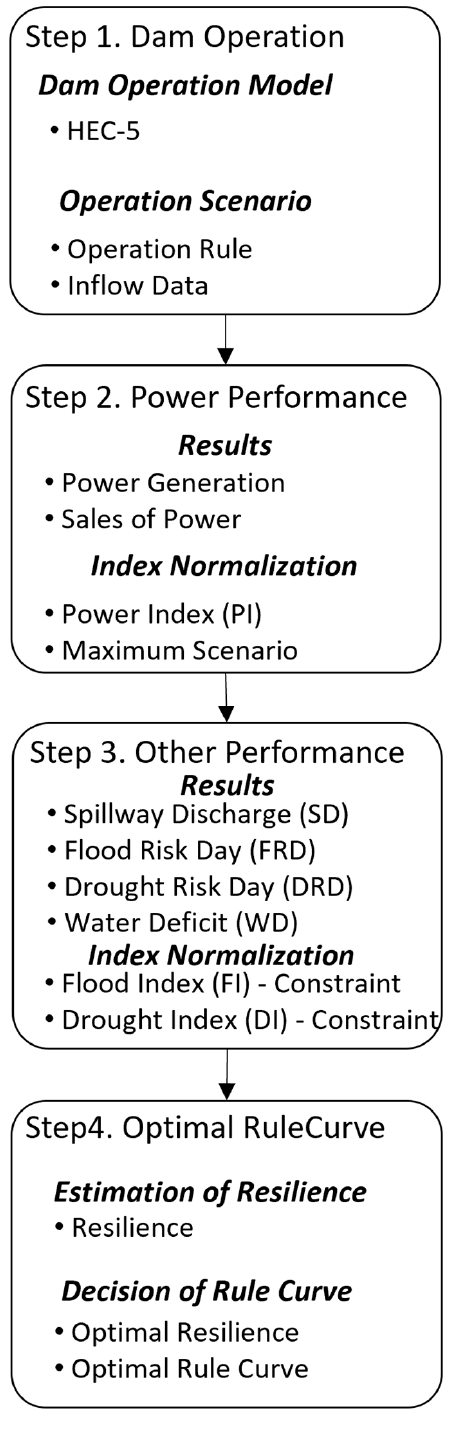
Figure 4. Assessment Methodology of Resilience.